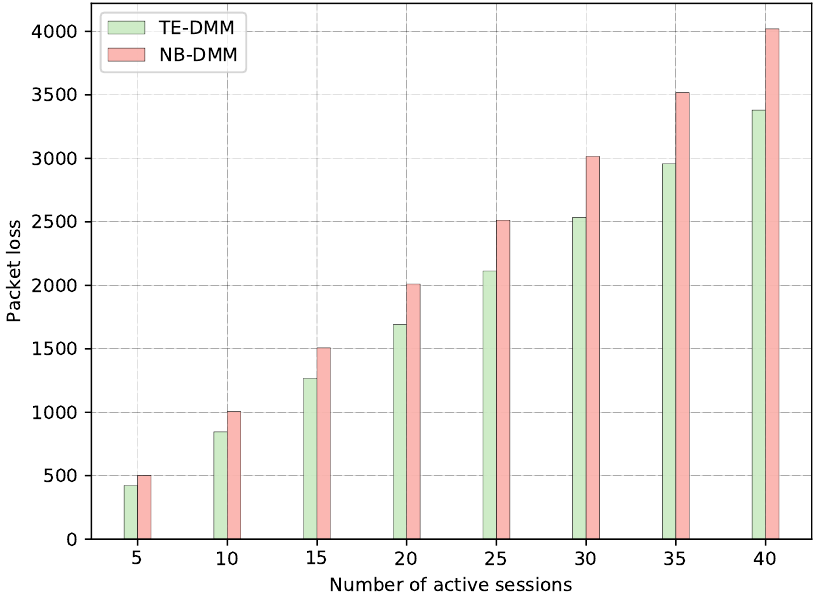
Figure 12. Packet loss evaluation: DMM and